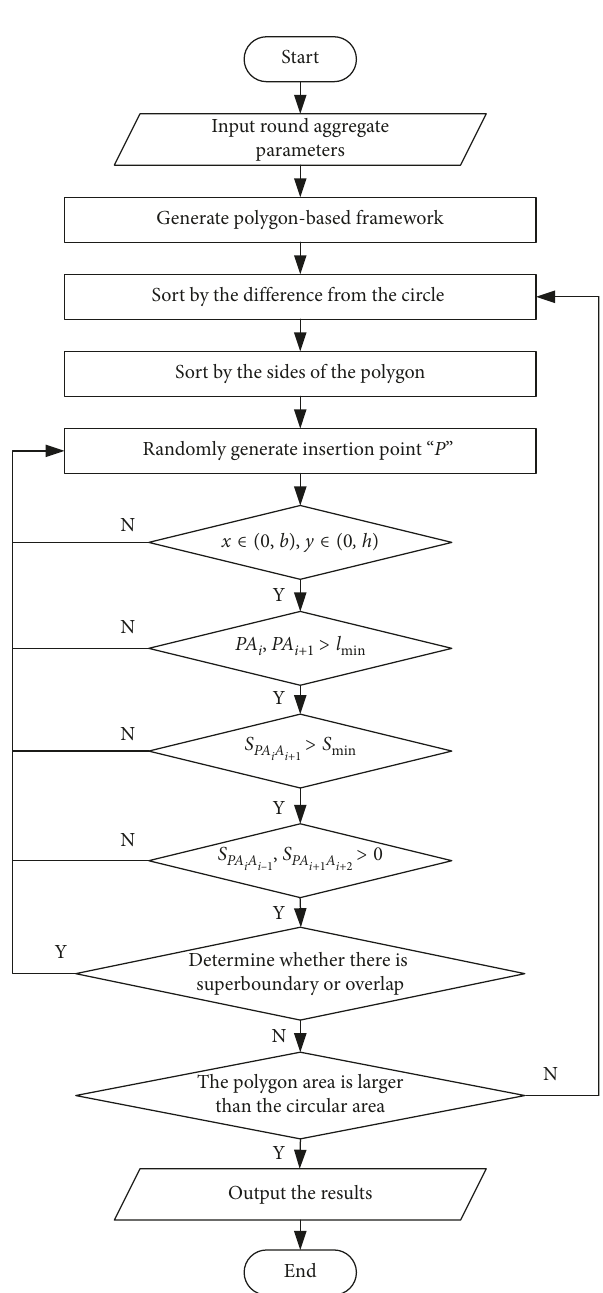
Figure 8: Convex extended subroutine